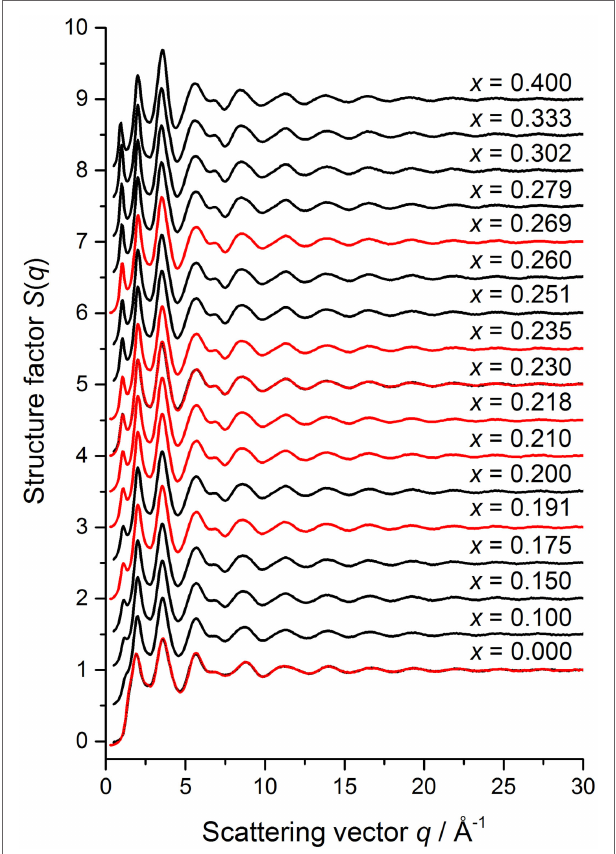
FIGURE 6 | The composition dependence of the measured total structure factors S ( q ) ≃ S NN ( q ) for the Ge x Se 1 (cid:0) x system. The GEM and SANDALS data sets are shown by the solid dark (black) and solid light (red) curves with vertical error bars, respectively, where the line thickness is greater than the size of the error bars at most q values. The curves for x > 0 have been displaced vertically for clarity of presentation.